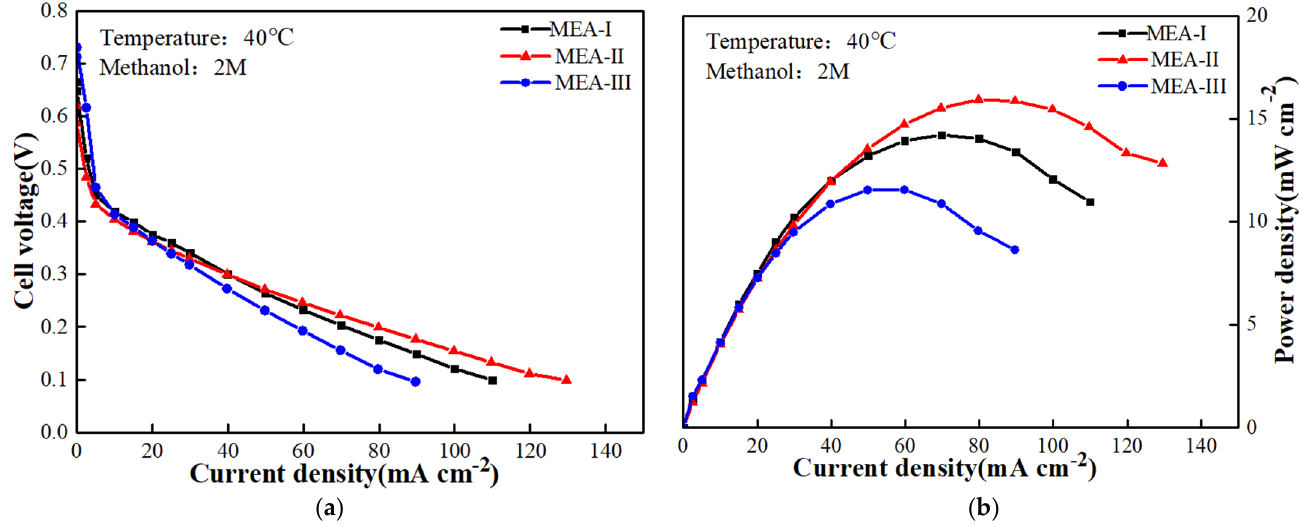
Figure 3. Comparison of the performance of DMFCs with different catalyst loading electrodes. ( a ) Polarization curves; ( b ) power density curves.